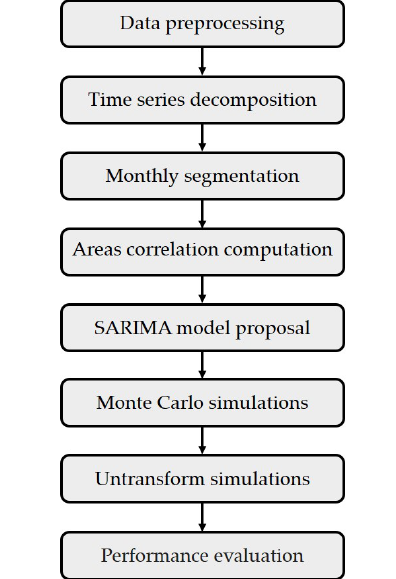
Figure 1. Flow chart for the